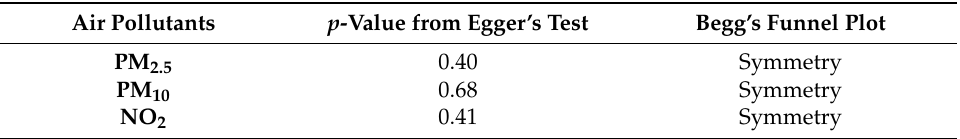
Table A2. Assessment of publication bias using Begg’s funnel plot and Egger’s